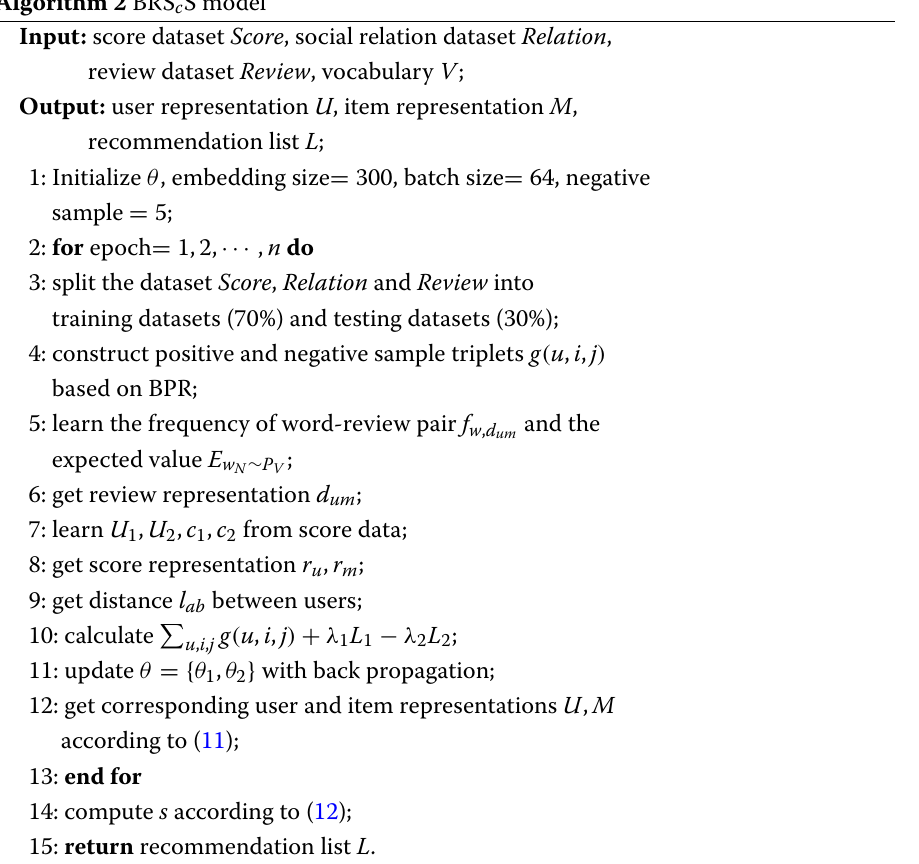
Algorithm 2 BRS c S